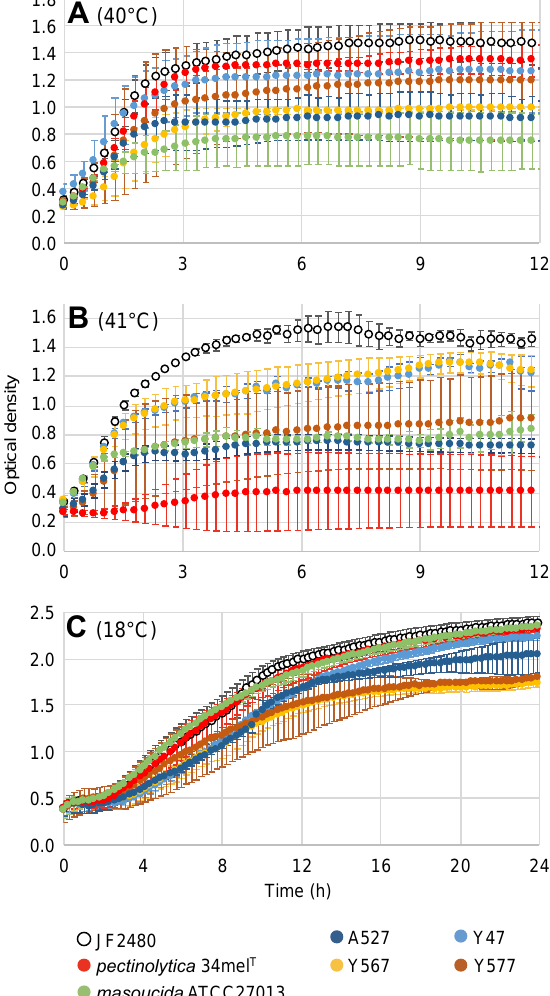
Figure 4. Growth curves for various A. salmonicida strains. The growth curves were determined at 40 ◦ C ( A ), 41 ◦ C ( B ) and 18 ◦ C ( C ) by measuring the optical density at 595 nm. The means of two ( A ) and three biological replicates ( B and C ) are shown for each strain. Each experiment was also performed in three technical replicates.